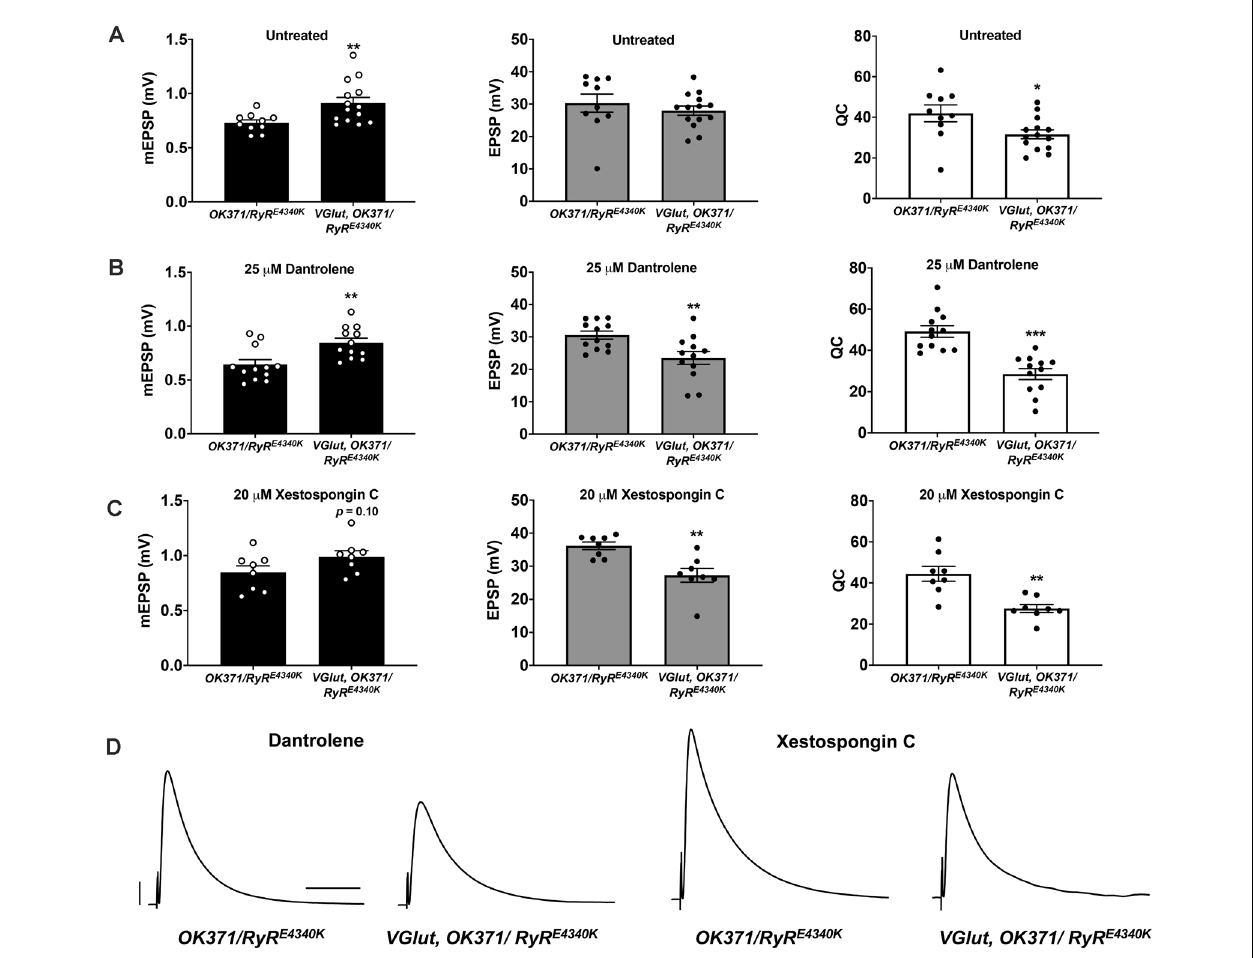
FIGURE 6 | Additional pharmaco-genetic combinations phenocopy the genetic conditions. (A) Raw data for mEPSPs (left); raw data for EPSPs (middle); raw data for QC (right) for untreated genotypes as shown; bars are averages and error bars are ± SEM. (B) Data as in (A) but with 25 µ M Dantrolene added to NMJ preps. (C) Data as in (A) but with 20 µ M Xestospongin C added to NMJ preps. (D) Representative EPSP traces. Scale bars are as in Figure 1 . * p < 0.05, ** p < 0.01, and *** p < 0.001 by Student’s t -test comparing a control dataset (no VGlut overexpression) vs. an experimental dataset (VGlut